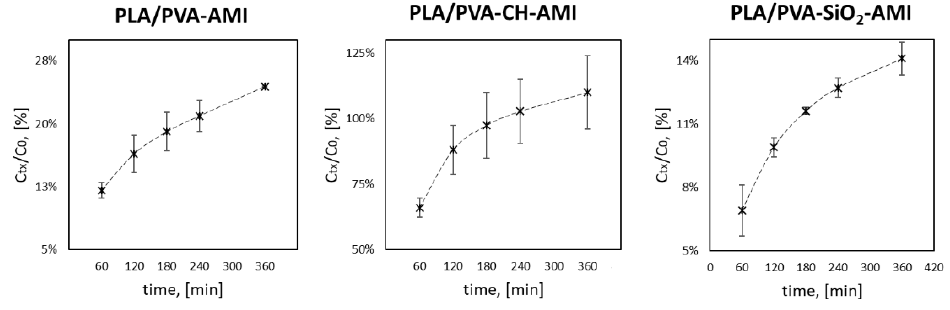
Figure 7. Simulation of AMI release according to OECD guidelines ( C tx —amount of AMI released after time t; C 0 —total amount of AMI in the material tested, n = 3).